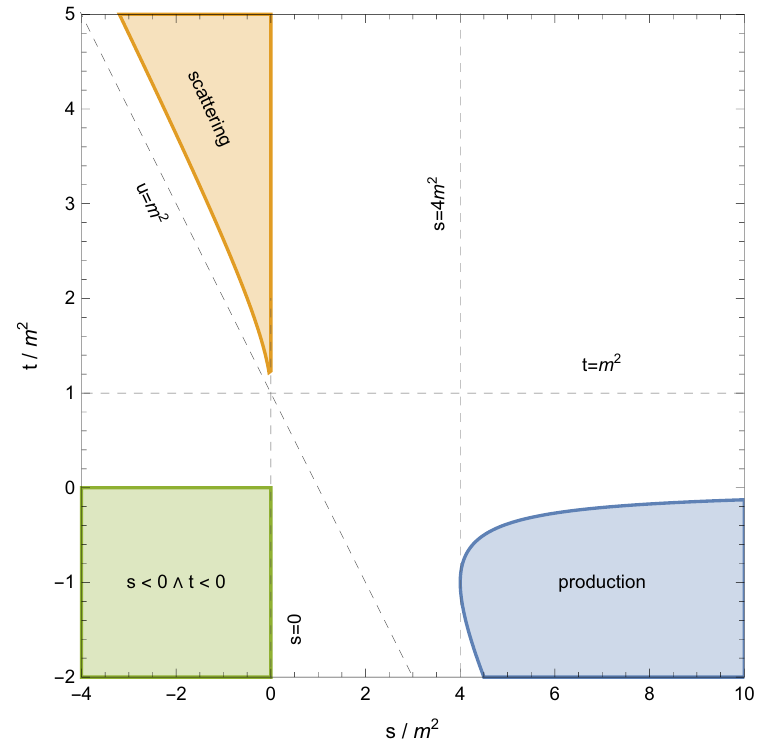
Figure 4. In the plot we show a representative portion of the kinematic phase space, parametrized in terms of ( s; t ). The region in which we solved the system of di(cid:11)erential equations, s; t < 0, is marked in green. The physical region for the s -channel production process, given in eq. (4.1), is highlighted in blue. In orange we also show the physical region for the t -channel process, given in eq. (4.2), which is relevant for (cid:22)e scattering. The dashed lines indicate the thresholds of the physical logarithms in eq.